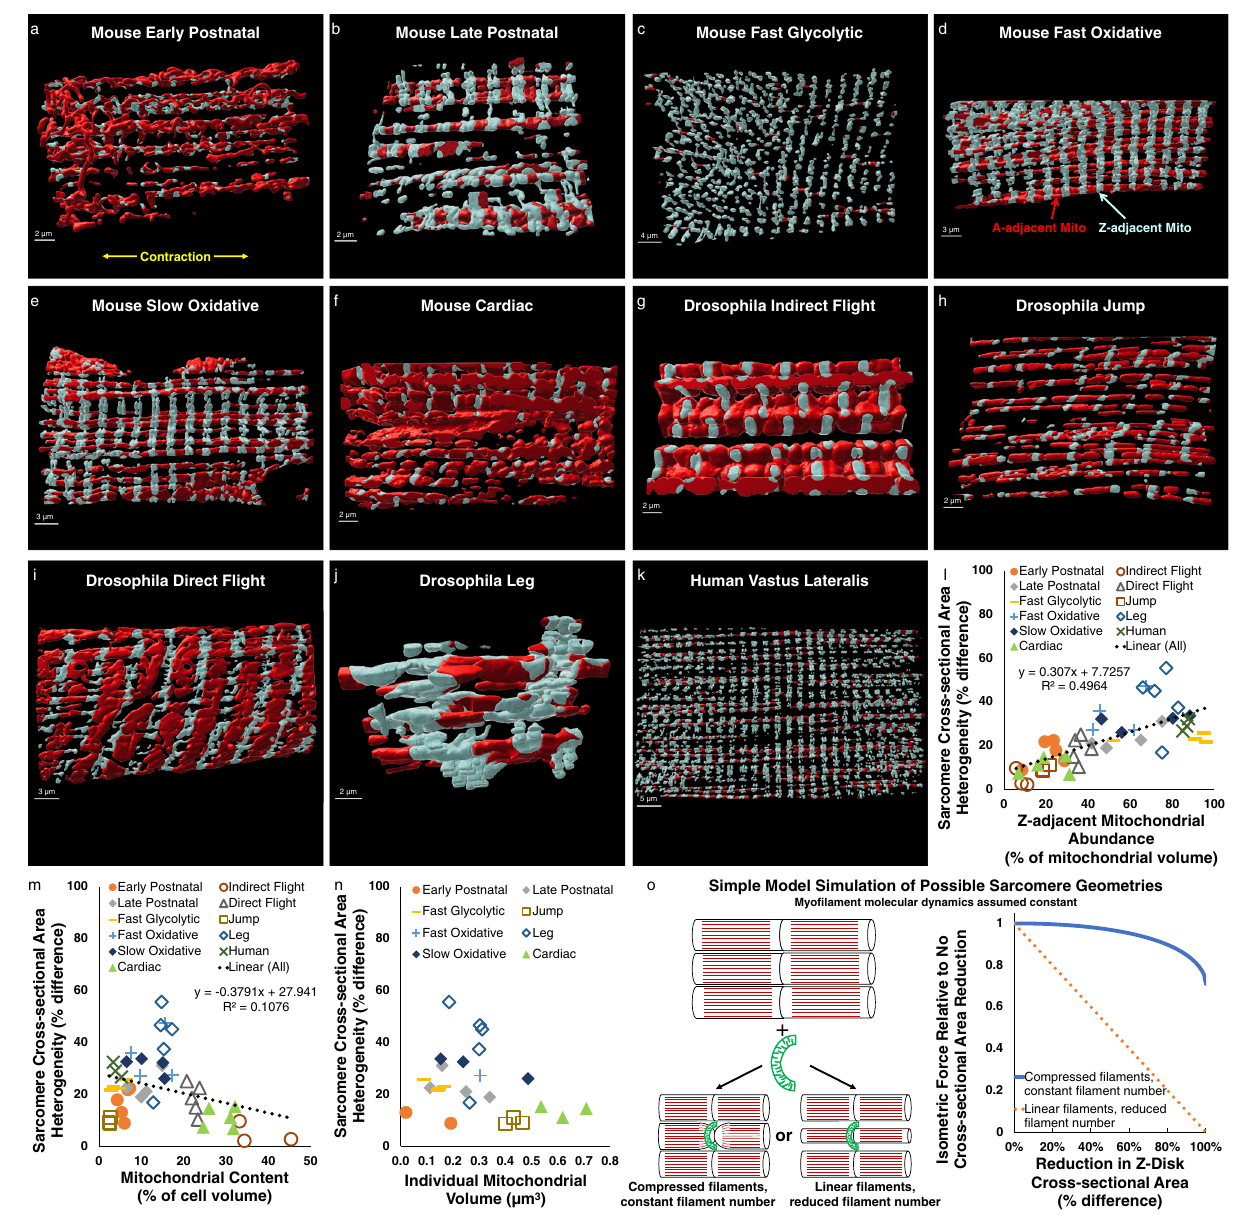
Fig. 2 | Magnitude of intrasarcomere cross-sectional area heterogeneity is related to mitochondrial location. a – k 3D rendering of representative mito- chondrial network structures from eleven muscle types from mouse, Drosophila , and human tissues showing Z-adjacent regions (light blue) and A-adjacent regions (red). l Strong linear correlation (black dotted line, linear regression, p <0.001) between Z-adjacent mitochondrial abundance and sarcomere cross-sectional area (CSA) heterogeneity. Individual points represent individual muscle cell values.